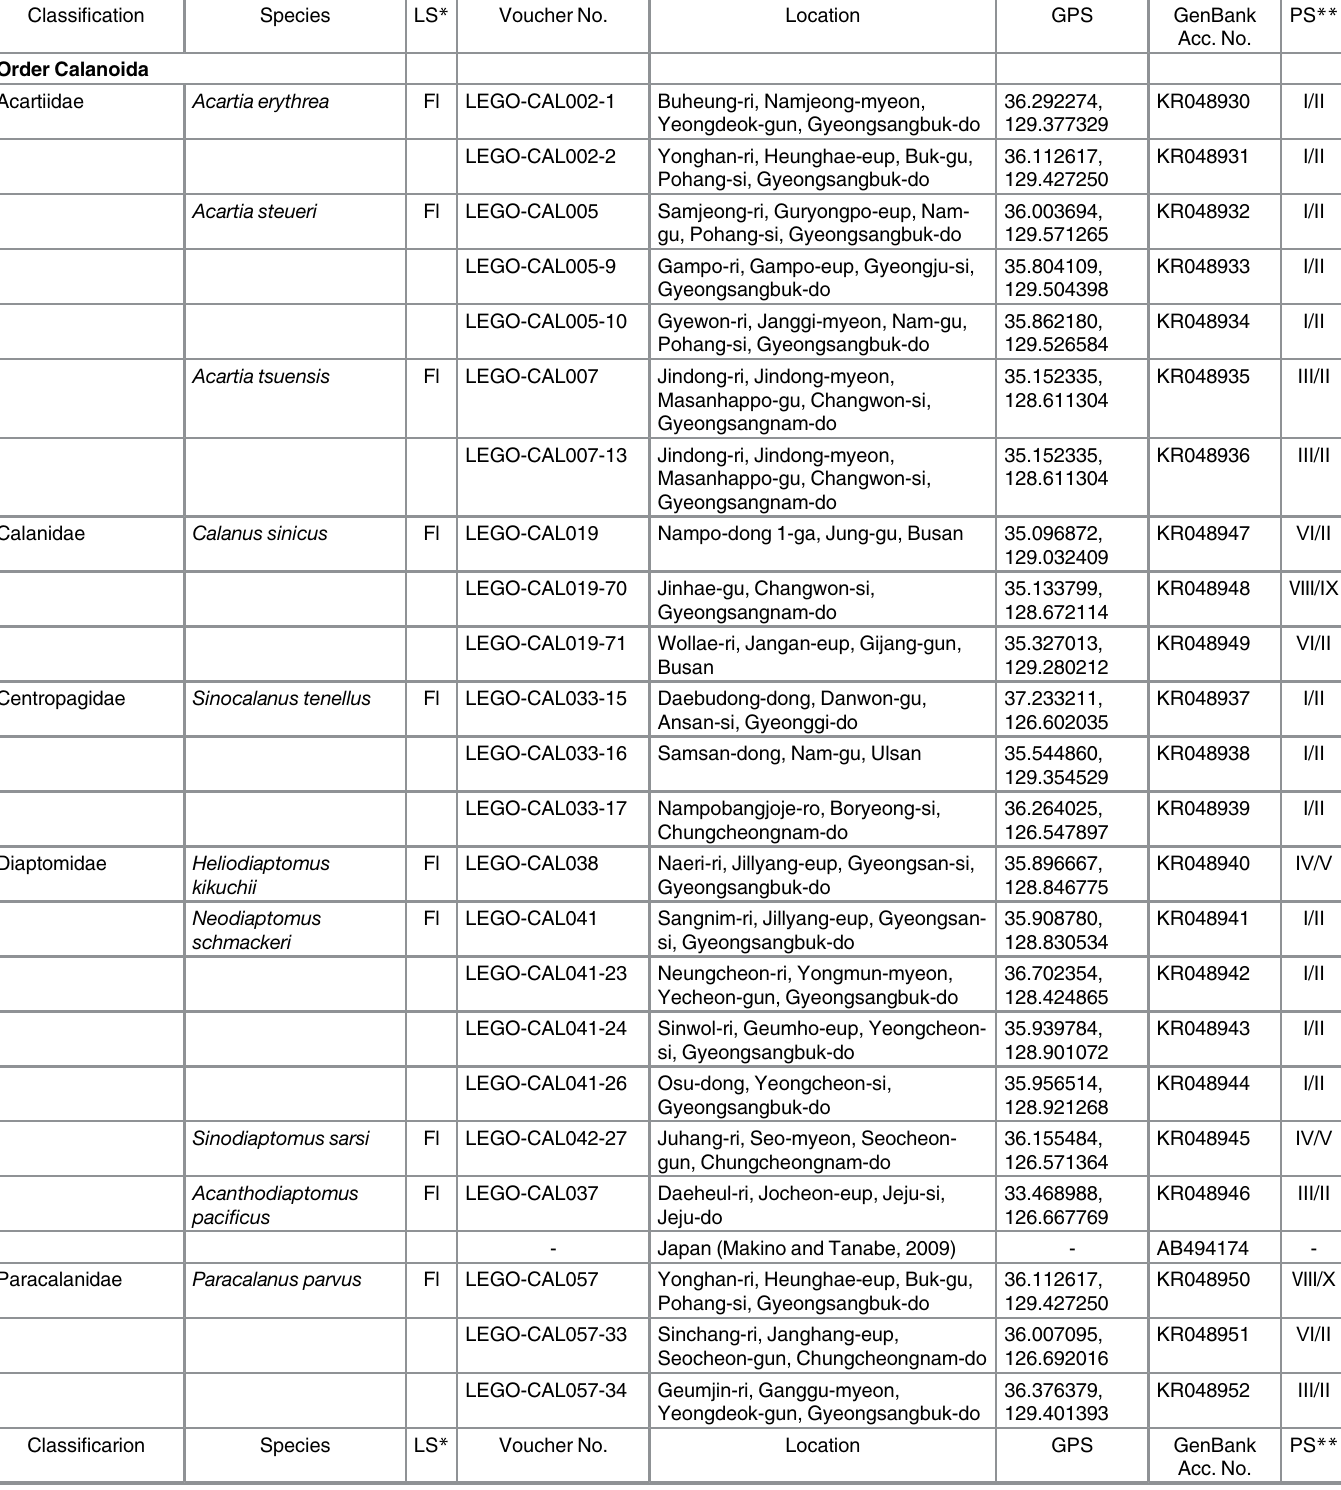
Table 1. Summary of classification, species name, adult life style, collection locality, GPS, GenBank accession numbers, and used PCR primers for 133 samples covering 94 copepod species examined